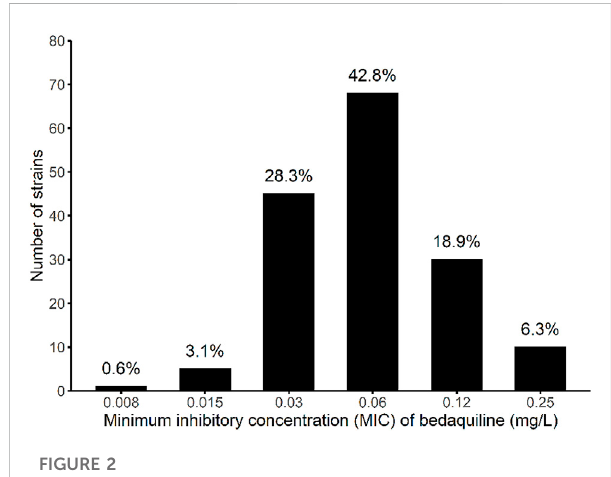
FIGURE 2 Mycobacterium tuberculosis minimum inhibitory concentration distribution of bedaquiline among the participants in the validation